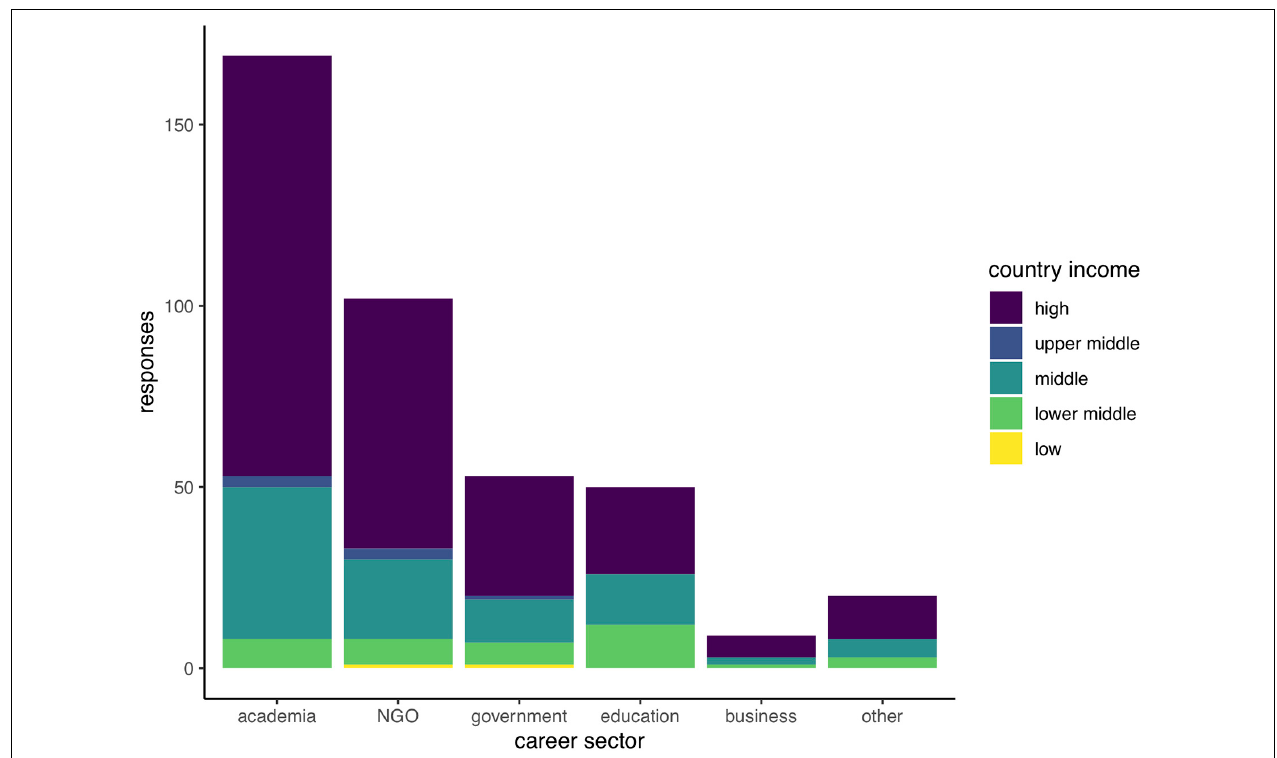
FIGURE 2 | Distribution of survey respondents by career sector and the World Bank definitions for the income of the country of residence (World Bank, 2019).